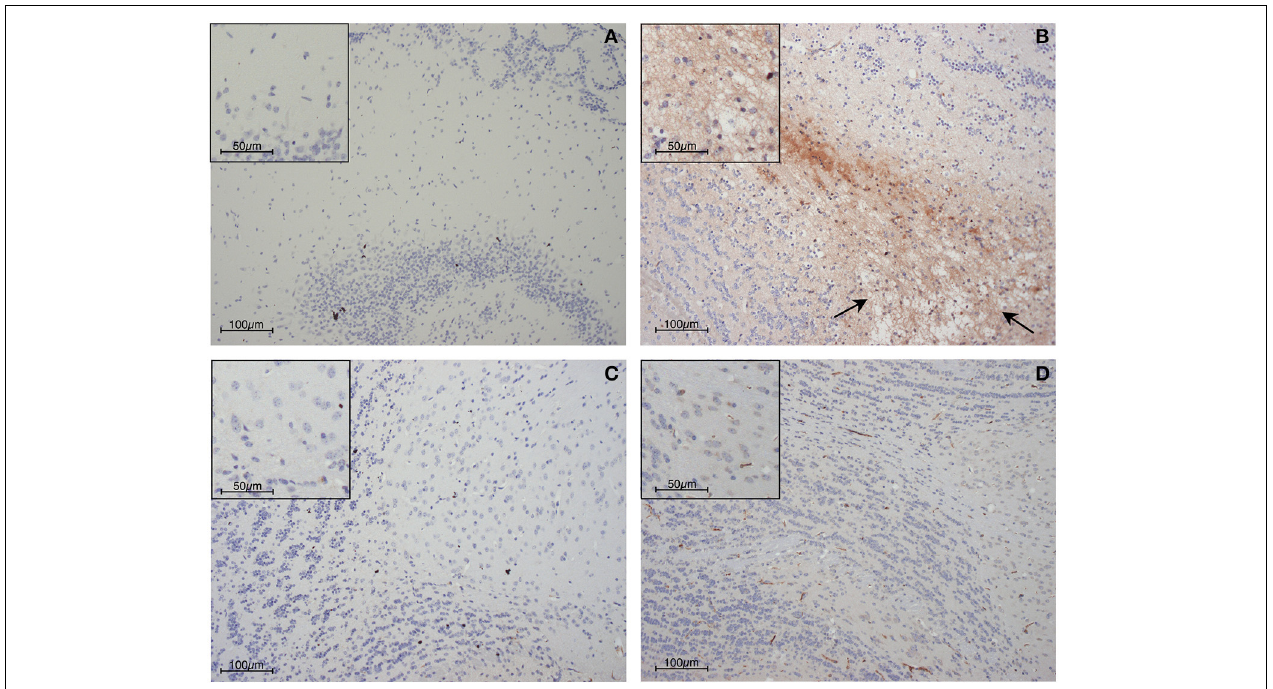
FIGURE 3 | Blood-brain barrier compromise during PbA infection, as determined by immunohistochemical detection of fibrinogen within the parenchyma of the olfactory bulb. (A) Uninfected control mouse; (B) PbA-infected wild-type mouse at day 6 post-inoculation; (C) PbA-infected